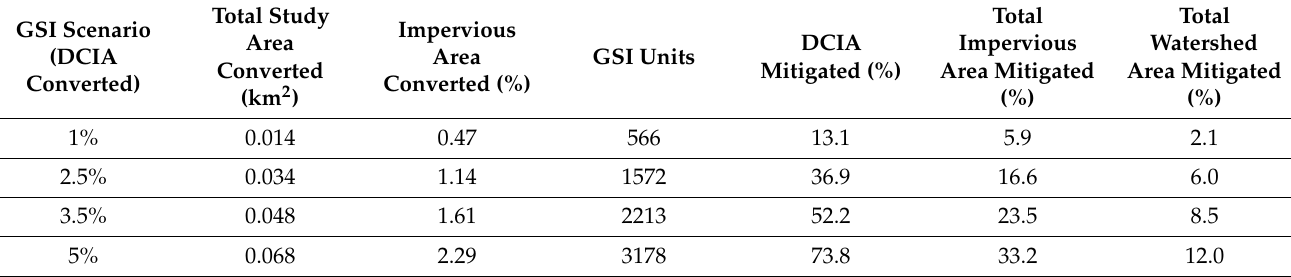
Table 3. Values of the total study area converted to GSI, percent of impervious area converted to GSI, a representative number of GSI units, percent of DCIA area mitigated (draining to a GSI), and percent of total impervious area mitigated for the four GSI